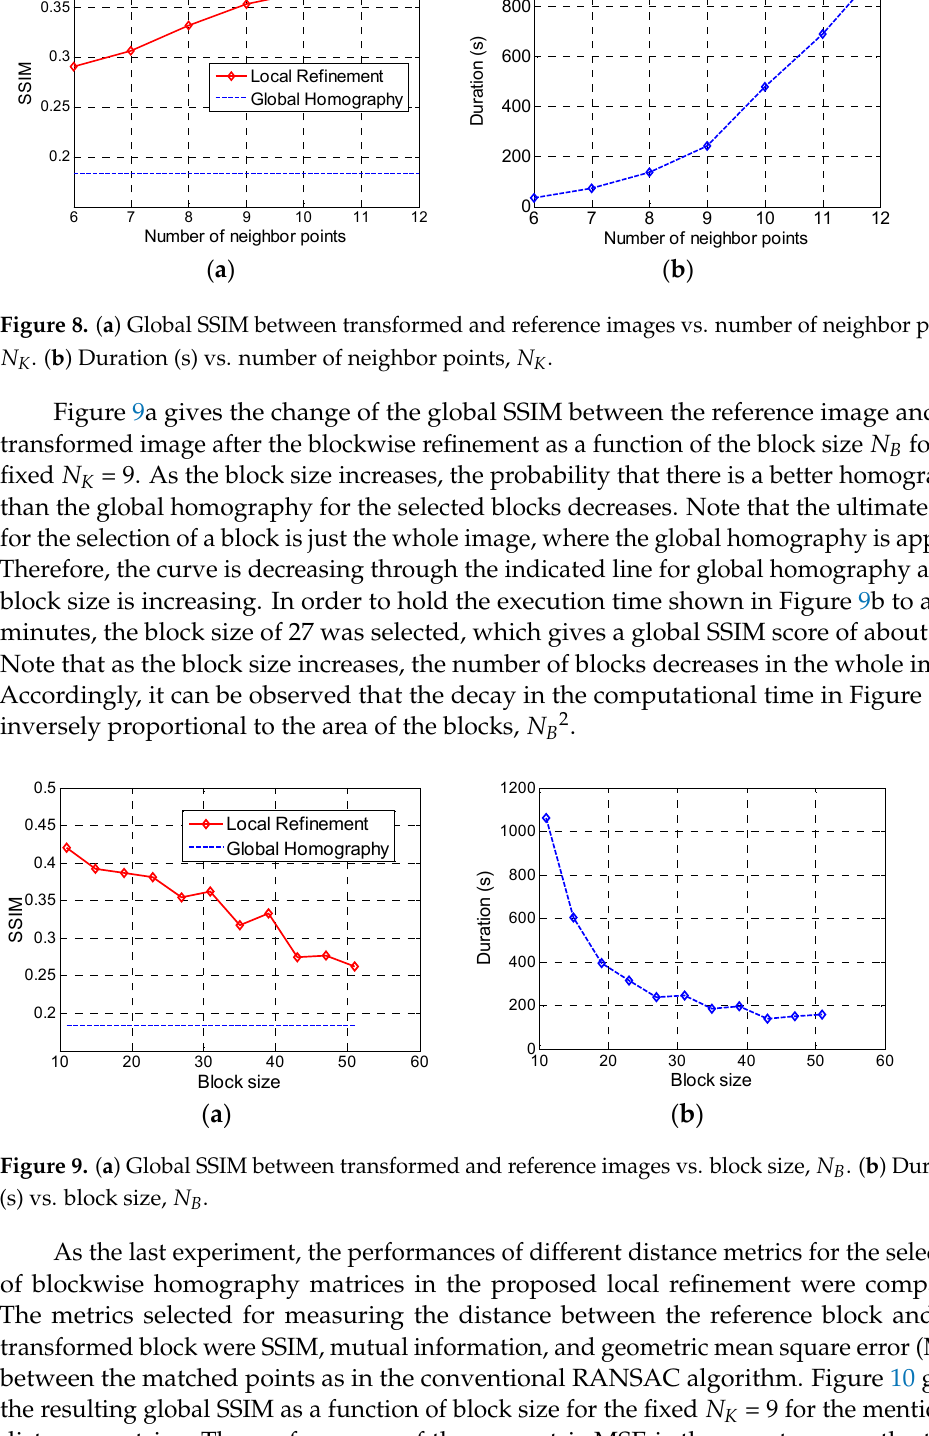
Figure 9. ( a ) Global SSIM between transformed and reference images vs. block size, N B . ( b ) Duration (s) vs. block size, N B